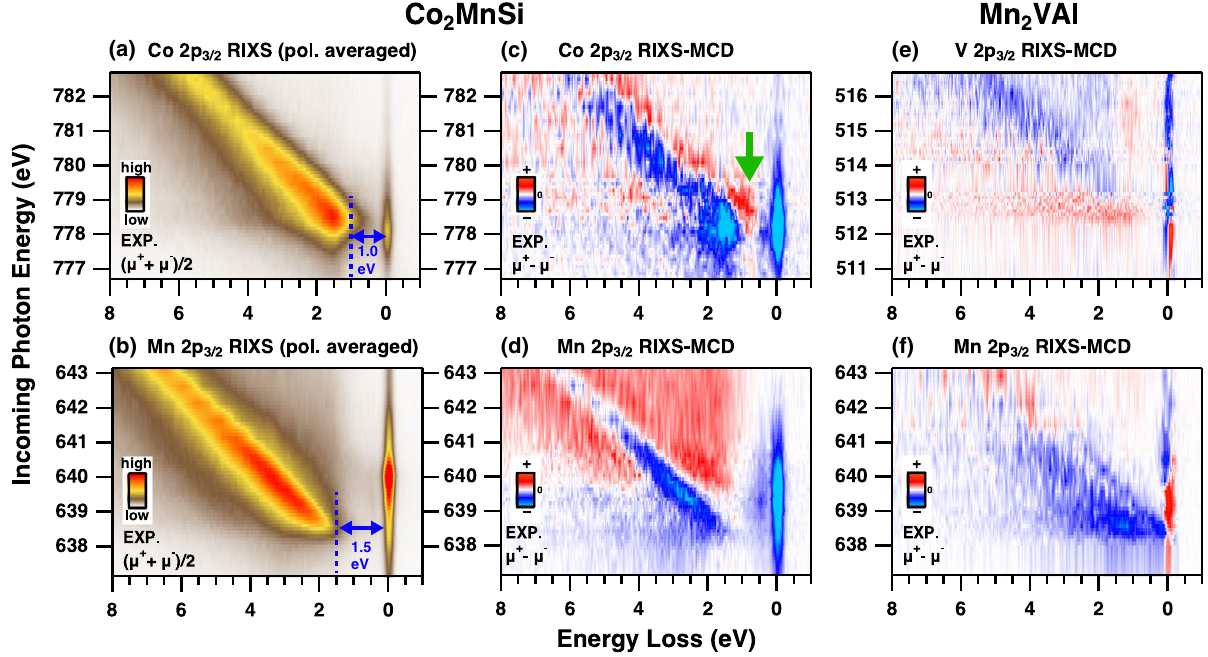
Figure 3. Intensity plot of the RIXS data for Co 2 MnSi obtained by the circularly polarized photons. The polarization averaged RIXS at the Co 2 p 3 / 2 edge ( a ) and at the Mn 2 p 3 / 2 edge ( b ), and the RIXS-MCD data for the Co and Mn edges in ( c , d ), respectively. The RIXS-MCD data for Mn 2 VAl obtained at the V and Mn 2 p 3 / 2 edges are also shown in ( e , f ). The gap energies in ( a , b ) are estimated by the energy difference between the elastic peak and the threshold of the RIXS structures as shown in Fig. the strong contrast between the positive and negative signals due to the m j = + 3 / 2 and − 3 / 2 components as shown in Fig. 4d–f. The core-level Zeeman splitting, which is one of the most important parameters for the spin-selective excita- tion, can be estimated by the energy difference between the m j = ± 3 / 2 components. To examine the estimation of the splitting energy, the m j resolved simulations for all m j components of 2 p 3 / 2 states are integrated along the loss energy axis as shown in Fig. 4g,h for Co and Mn edges. The difference of the two threshold energies of the m j = ± 3 / 2 components, estimated at the half maximum of their MCD peaks as indicated by vertical bars, yields 0.5 and 1.0 eV for Co and Mn edges, representing the Zeeman splitting (see “Methods:Theory”). The good agree- ment with the experimental results indicates that the calculated values of Zeeman splitting were reasonable, and also confirms the validity of the simulation method. Note that the m j = ± 1 / 2 contributions, which cause spin-flip (non spin-conserving) excitations due to the spin degeneracy from the strong spin-orbit coupling (SOC) of the 2 p states, contribute much less to the RIXS-MCD than those of the m j = ± 3 / 2 components, (see Supplementary materials). This is due to the difference of the transition probabilities of the dipole-allowed transitions, which are applied for both excitation and decay channels in the RIXS process. Figure 5a upper panel shows the incoming photon-energy dependence of the experimental RIXS-MCD intensity of the Co 2 p 3 / 2 edge integrated within 0.5 eV full width ( ± 0.25 eV) around the energy loss of 1.6 eV (1.0 eV) corresponding to the m j = − 3 / 2 (+3/2) component as shown by yellow hatched regions in Fig. 5b. The peak of resonance for the m j = − 3 / 2 contribution is located at 778.2 eV ( h ν 1 = 0.5 eV), and the delayed resonance of m j = + 3 / 2 components is observed at 778.9 eV ( h ν 1 = 1.2 eV) due to the core-level Zeeman splitting. The resonance energies for both m j = ± 3 / 2 components are consistent with the theoretical simulations as shown in the lower panel of Fig. 5a, which are extracted from the results in Fig. 5c. The experimental RIXS-MCD spectra obtained at the photon energies corresponding to the m j = ± 3 / 2 resonance peaks in Fig. 5a are displayed in the top panel of Fig. 5d. The m j = − 3 / 2 spectrum recorded at 778.2 eV shows the down-spin gap E g ↓ of 0.9 eV estimated from the onset of the fluorescence MCD signals (see Supplementary materials), which is comparable to the simulation in the middle panel as well as PDOS of the Co 3 d states as shown in Fig. 4j. On the other hand, the RIXS-MCD spectrum obtained at the m j = + 3 / 2 resonance at 778.9 eV (top panel in Fig. 5d) shows the positive MCD signals around 1 eV, which is consistent with the theoretical simulation at h ν 1 of 1.2 eV (middle panel in Fig. 5d). These positive MCD signals are mainly due to the m j = + 3 / 2 contributions with the up-spin components as shown in the m j -resolved spectra obtained at h ν 1 of 1.2 eV in the bottom panel of Fig. 5d. Most important is that the up-spin components are observed in the down-spin gap as shown in Fig. 1b. Since the Co 3 d states contribute mainly to the electronic structures in the vicinity of the E F as supported by the valence band HAXPES (see Supplementary materials), the up-spin components in the down-spin gap contribute to the electronic states at the E F , proving the halfmetallic electronic structures of the Co 3 d states. Note that the low energy excitation around 0.5 eV (top panel of Fig. 5d) is not observed in the DOS-based theory, and thus it is possibly due to the spin wave excitations predicted by the theoretical simulations 24,25 .